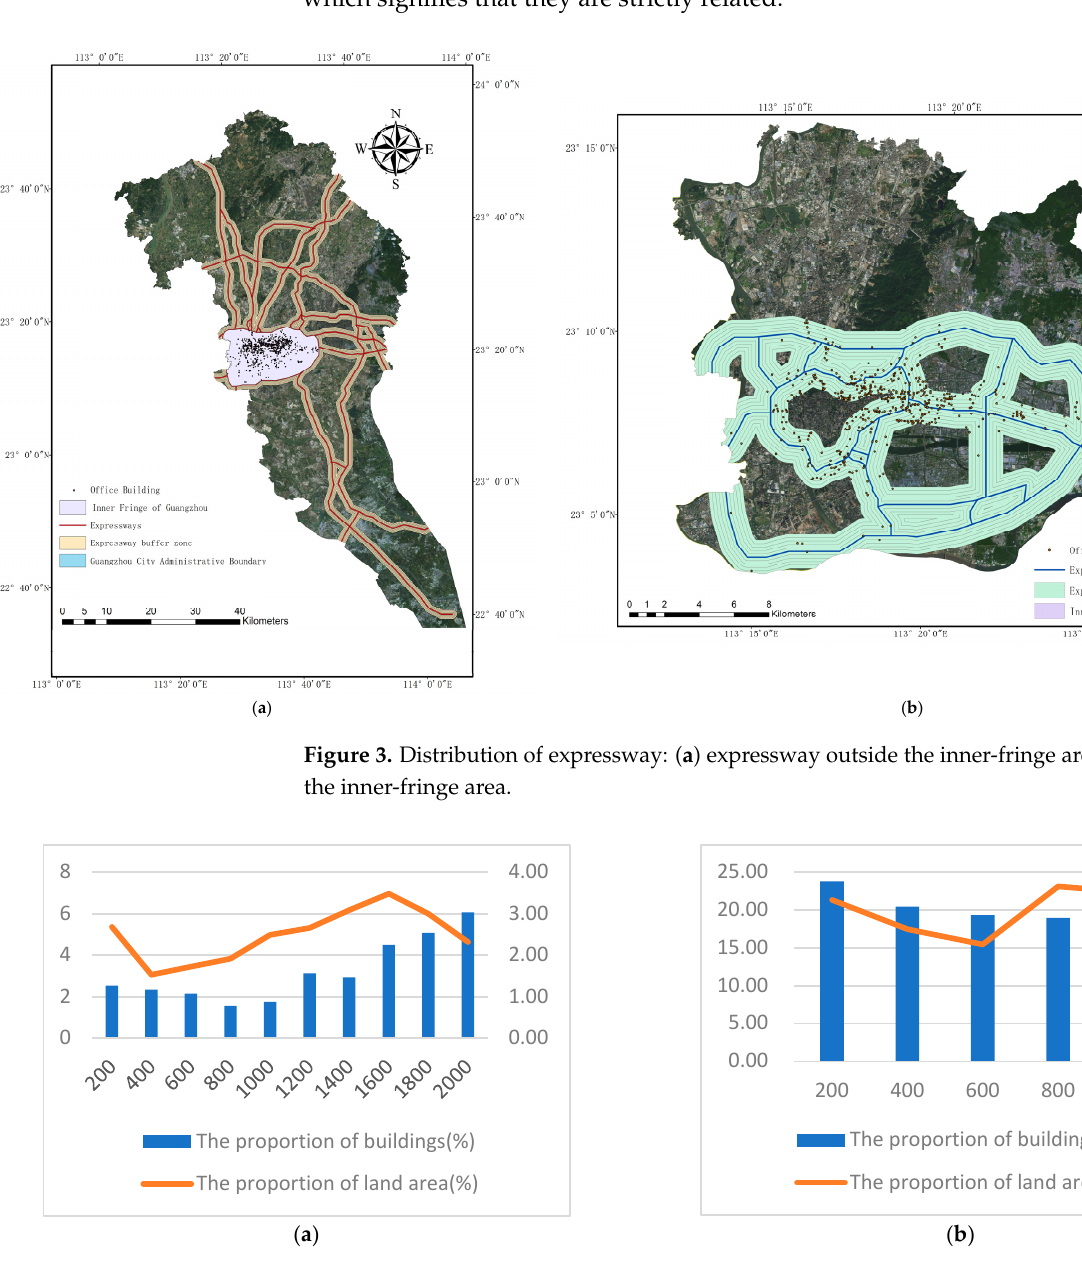
Figure 4. The corridor effect of expressway with different locations: ( a ) expressway outside the inner-fringe area; ( b ) expressway in the inner-fringe area.